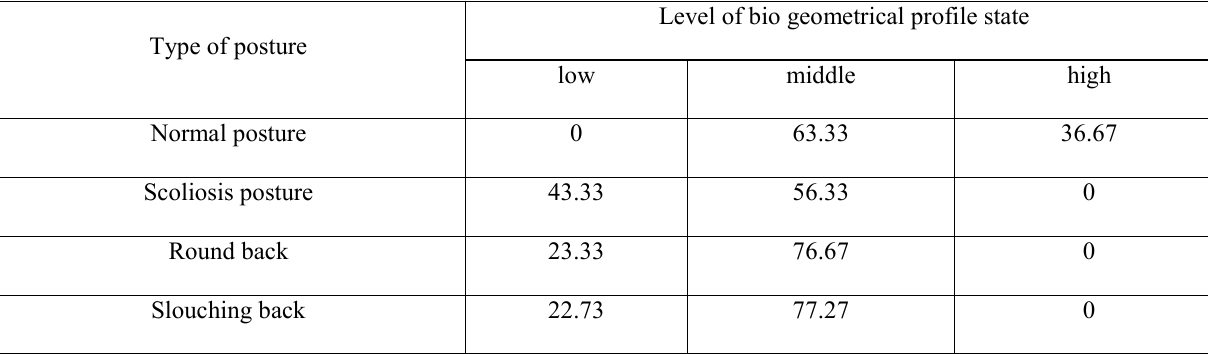
Distribution of students by state of posture’s bio-geometrical profile,